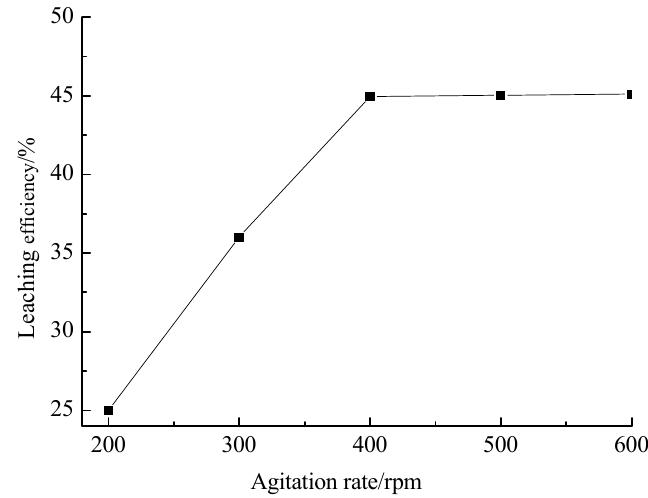
Figure 8. Effect of agitation rate on zinc extraction.